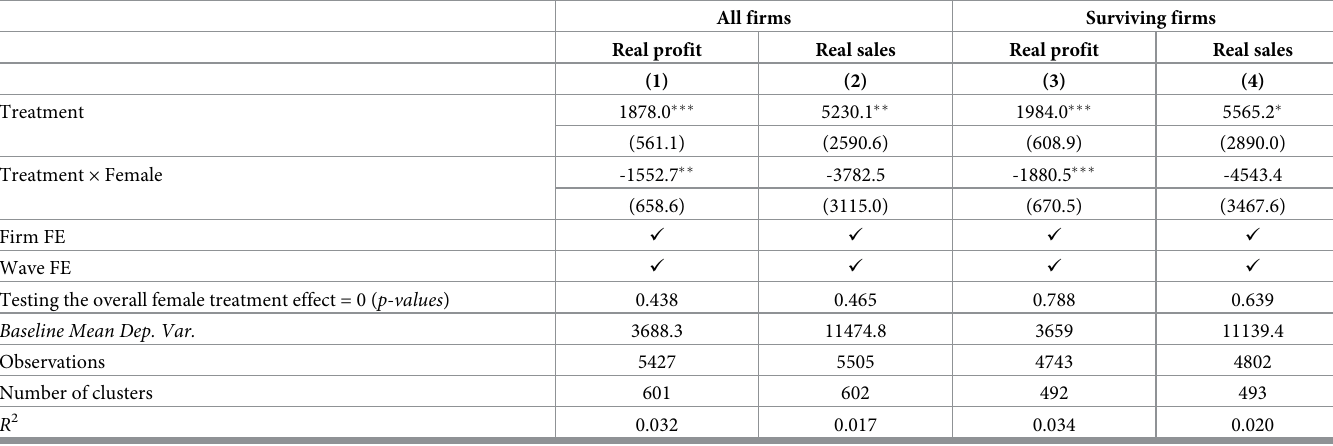
Table 3. Different treatment impacts on the performance of female-owned firms and male-owned firms.